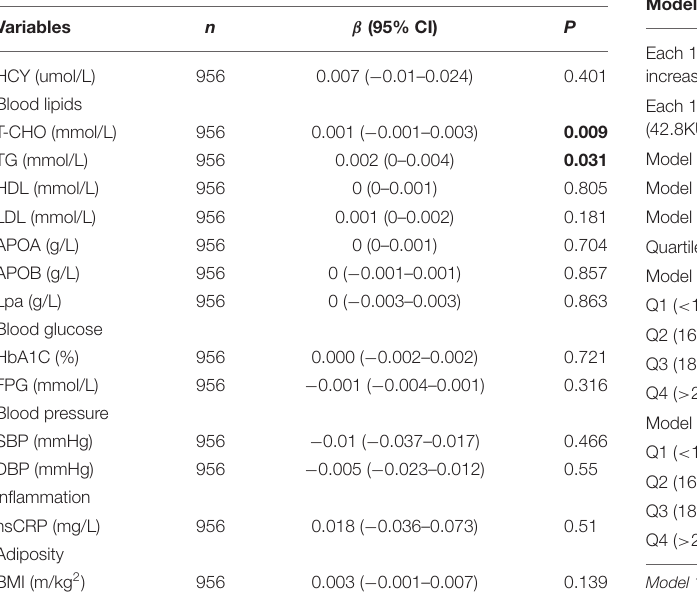
TABLE 4 | Associations of C1q and CAD.